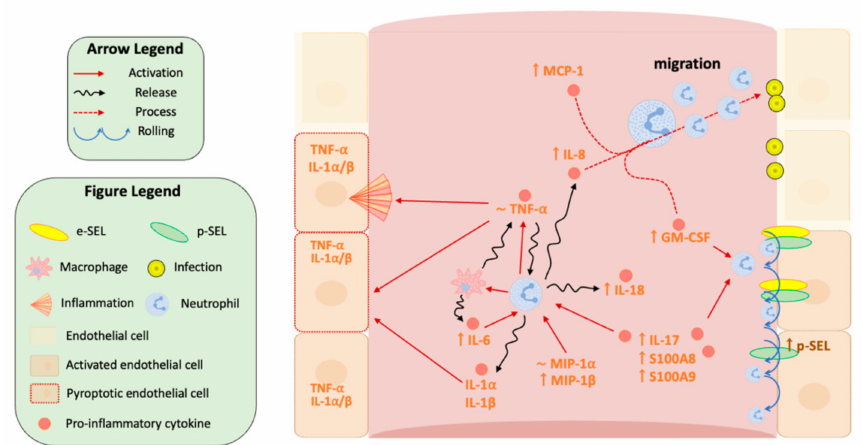
Figure 8. Graphical scheme of neutrophil immune response in septic shock patients. The upper arrow indicates overexpression; the lower arrow indicates down-regulation, ∼ indicates no variation in comparison to control samples. Orange names are pro-inflammatory cytokines, green names are anti-inflammatory cytokines, blue names are cells. A complete scheme is presented in Supplementary Materials (Figure